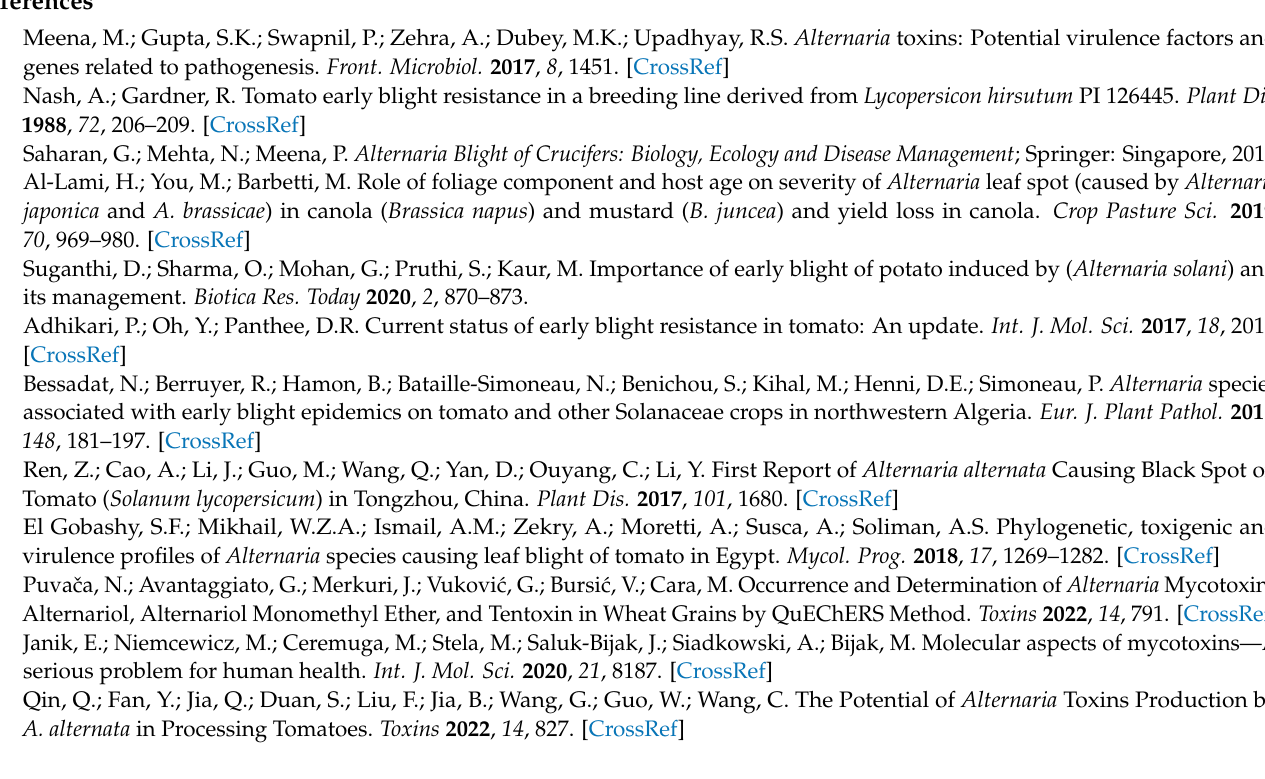
Table S1: Reference sequences retrieved from GenBank database used for phylogenetic